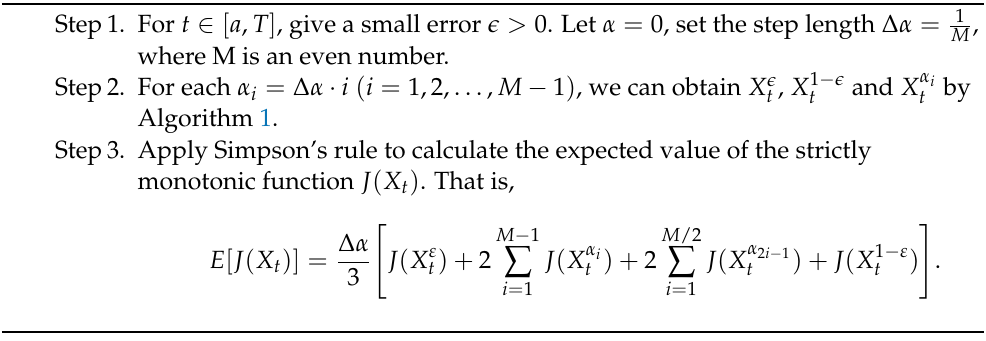
Algorithm 2: Expected value of the solution of a Caputo–Hadamard